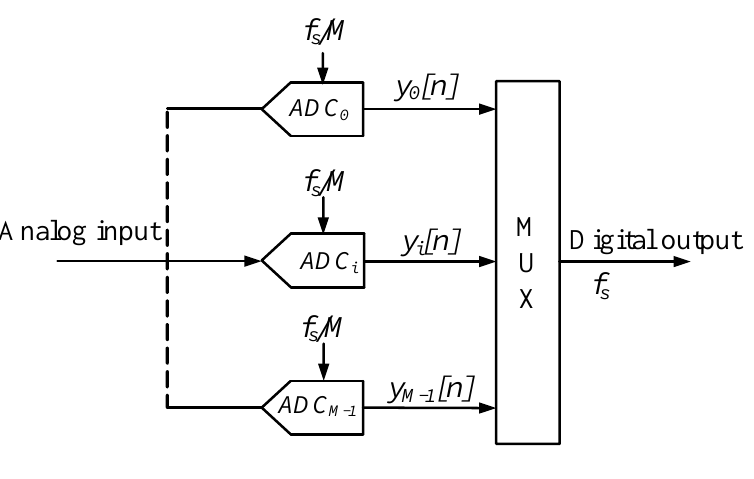
Figure 1. Model of an M -channel